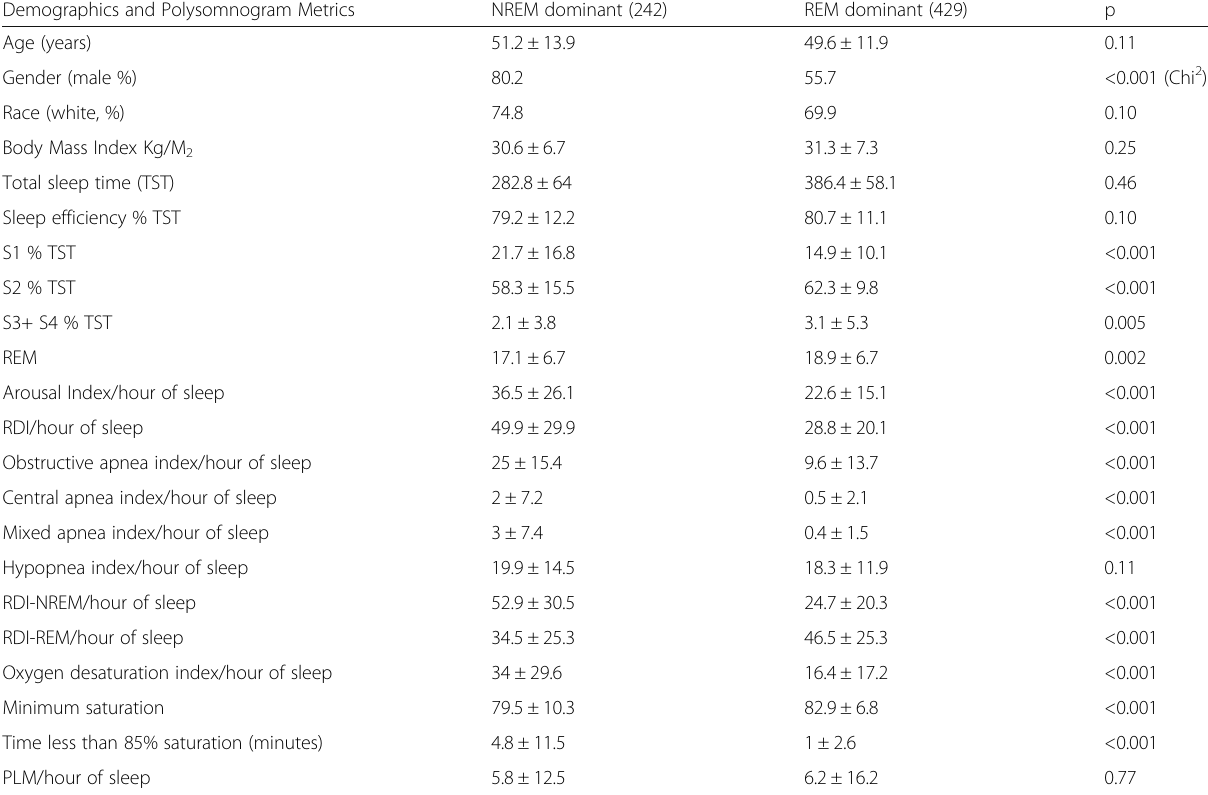
Table 7 NREM vs. REM dominance: clinical and polysomnographic